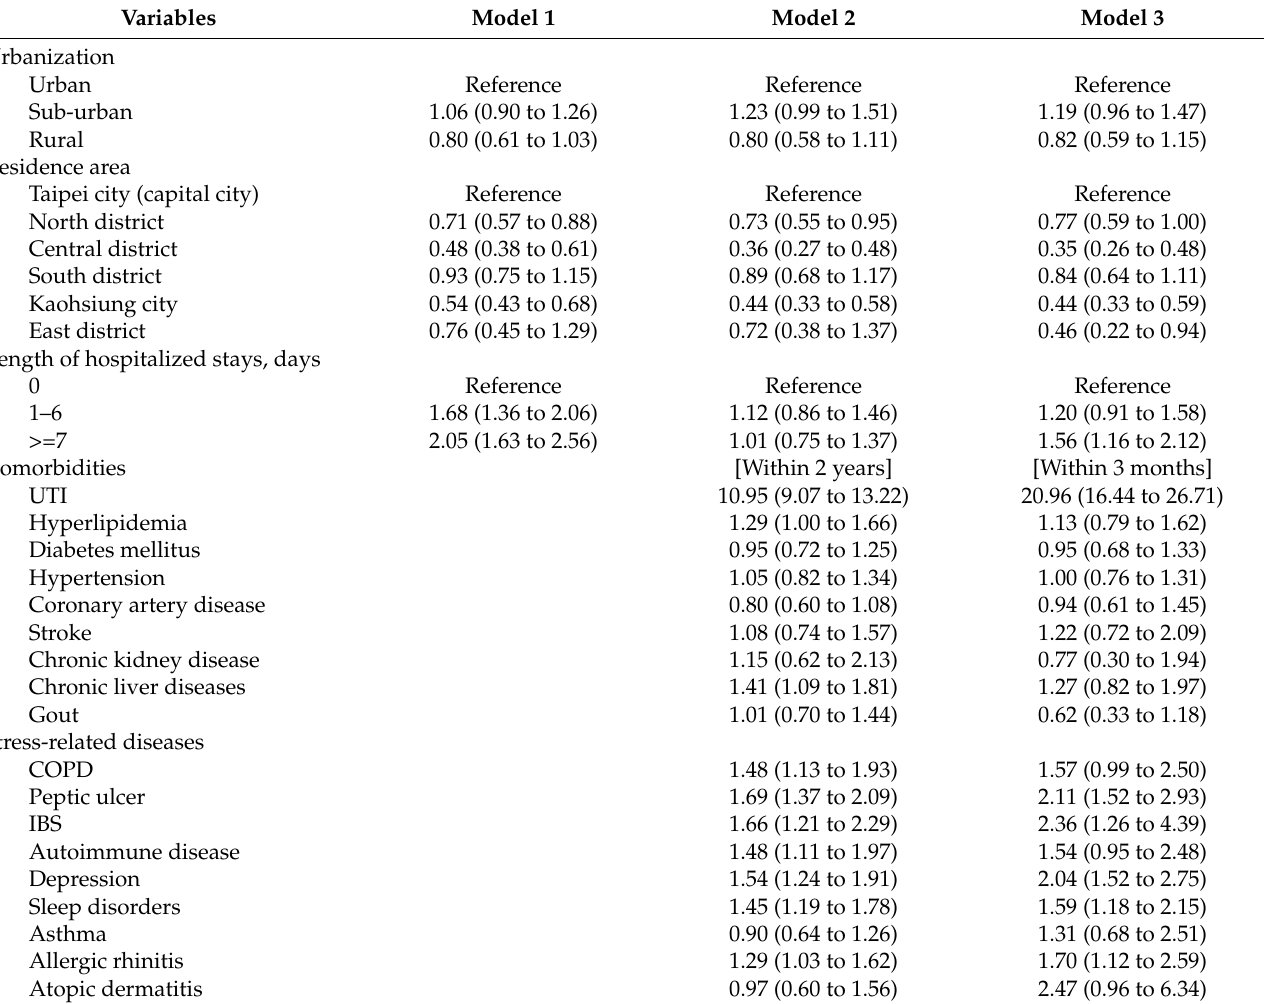
Table 3. Conditional logistic regression for estimating odds ratio of interstitial cystitis in specific variables.